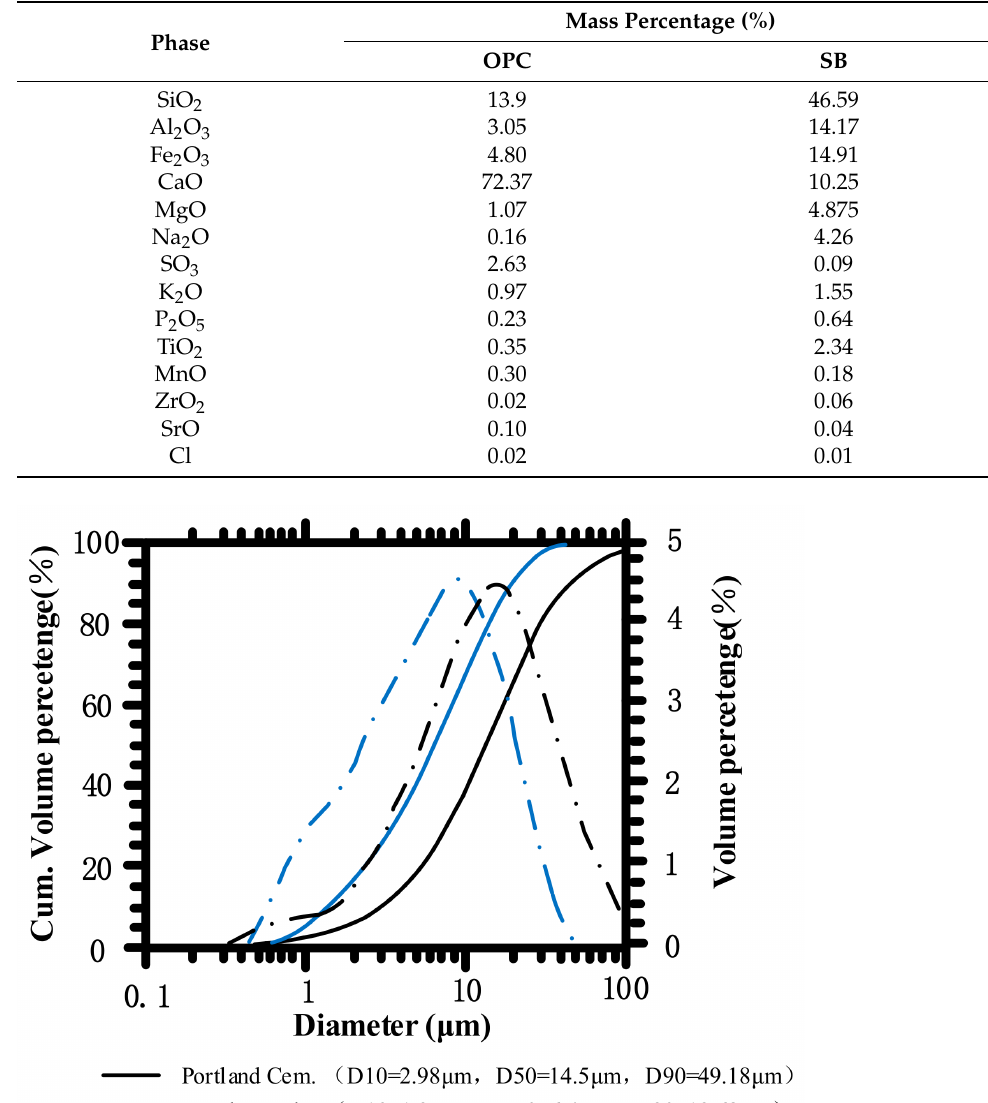
Figure 1. Particle size distributions of OPC and